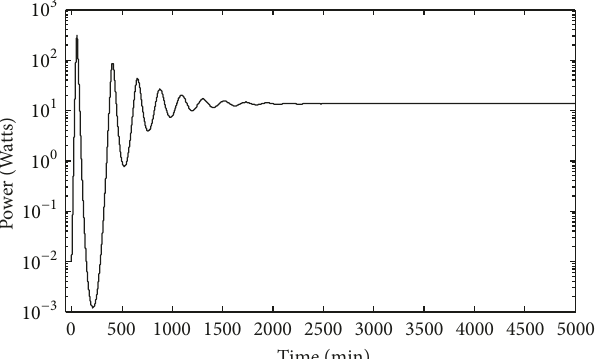
Figure 4: Power versus time for thermal hydraulic feedback